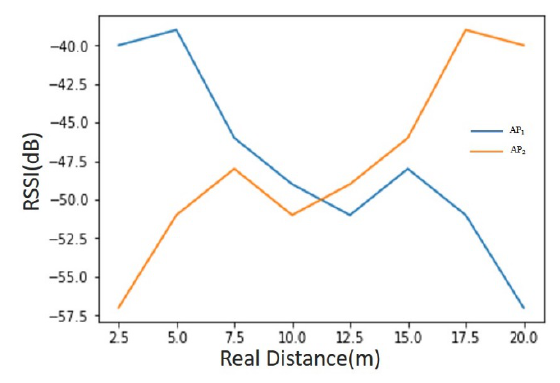
Figure 16. RSSI distributions of AP 1 and AP 2 after location adjustment